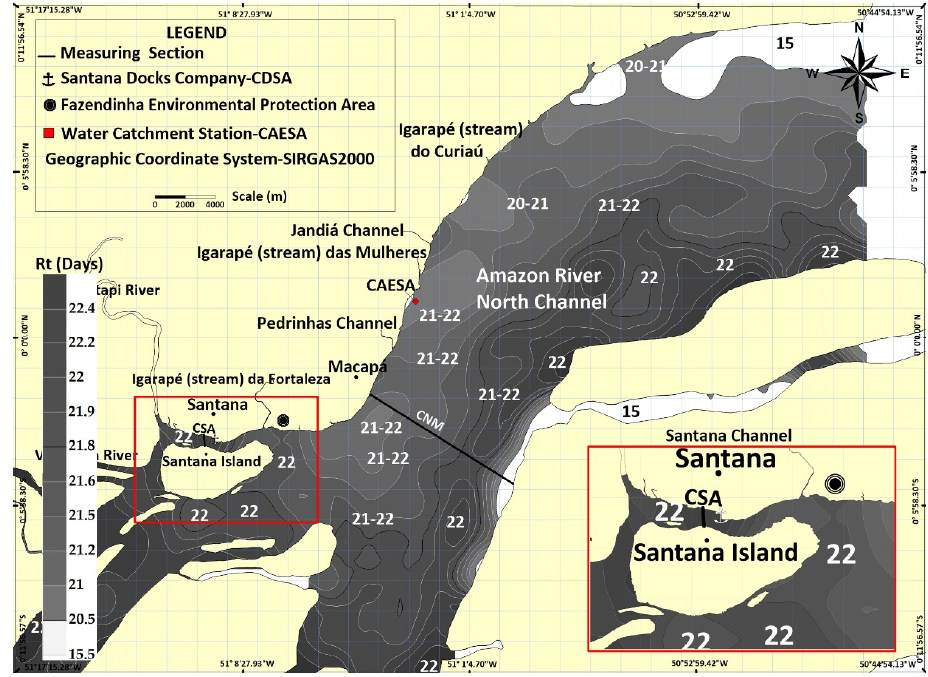
Figure 12. CNM and CSA’s water residence time in November at time units expressed in days. Geographic Coordinate System: Sirgas2000. Geographic Coordinate System: